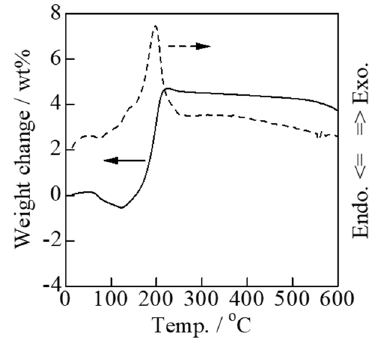
Figure 10. TG–DTA curves of Tl 2 O.